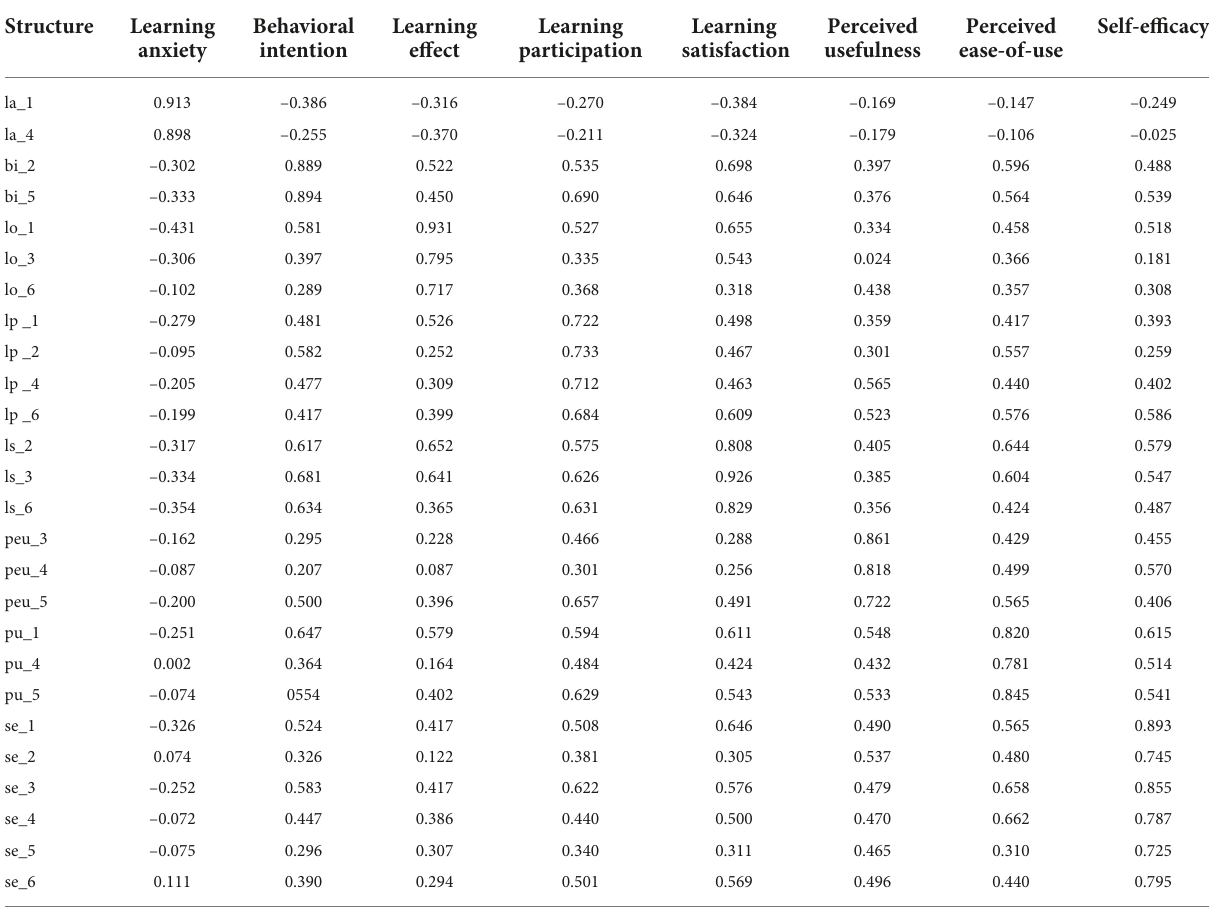
TABLE 3 Cross-loadings of all dimensions in the SPOC-AIOT scale.